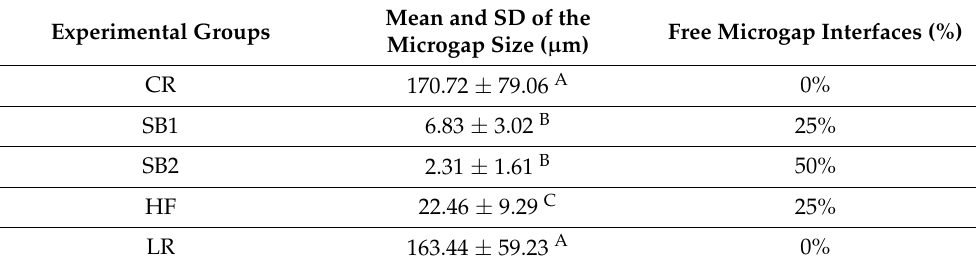
Table 2. Means and standard deviations (SDs) of the width of microgaps of each experimental group formed after thermocycling. CR: control; SB1: air abrasion with 29 µ m Al 2 O 3 particles; SB2: air abrasion with 53 µ m Al 2 O 3 particles; HF: hydrofluoric acid gel + silane; LR: Er,Cr:YSGG laser treatment. Experimental Groups